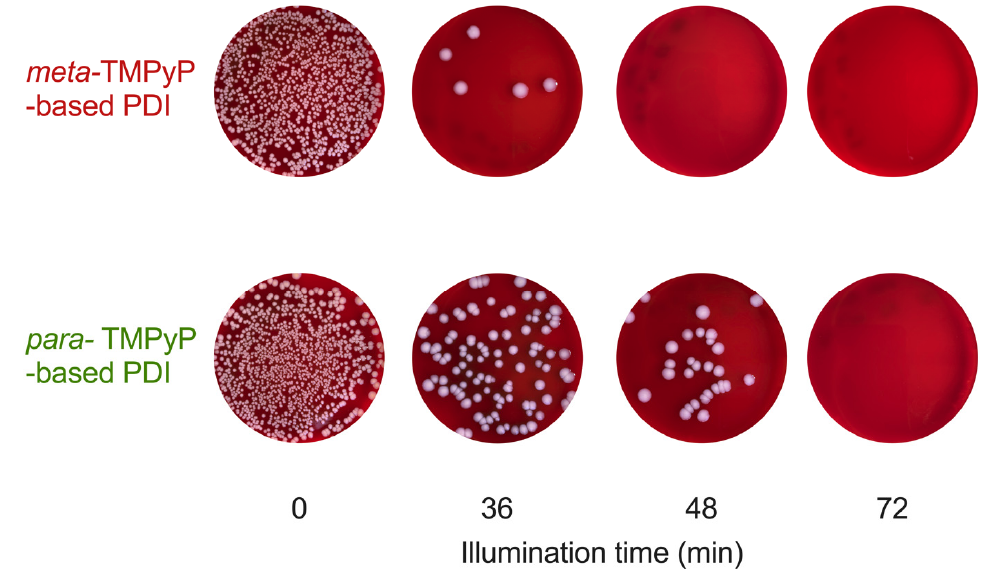
Figure 5. Photographic representation of multidrug-resistant Escherichia coli cultures after photodynamic inactivation with meta -TMPyP versus para -TMPyP . After treatment with photosensitizer (PS) only without illumination (400 µM; 0 min), no reduction of bacterial density was observed, while cultures treated with photodynamic inactivation (PS and light application; PDI; n = 3) showed time-dependent reduction of bacterial growth (36–72 min of illumination; light dose 28–56 J/cm 2 ). Please note that application of meta -TMPyP led to more pronounced effects than para - TMPyP .